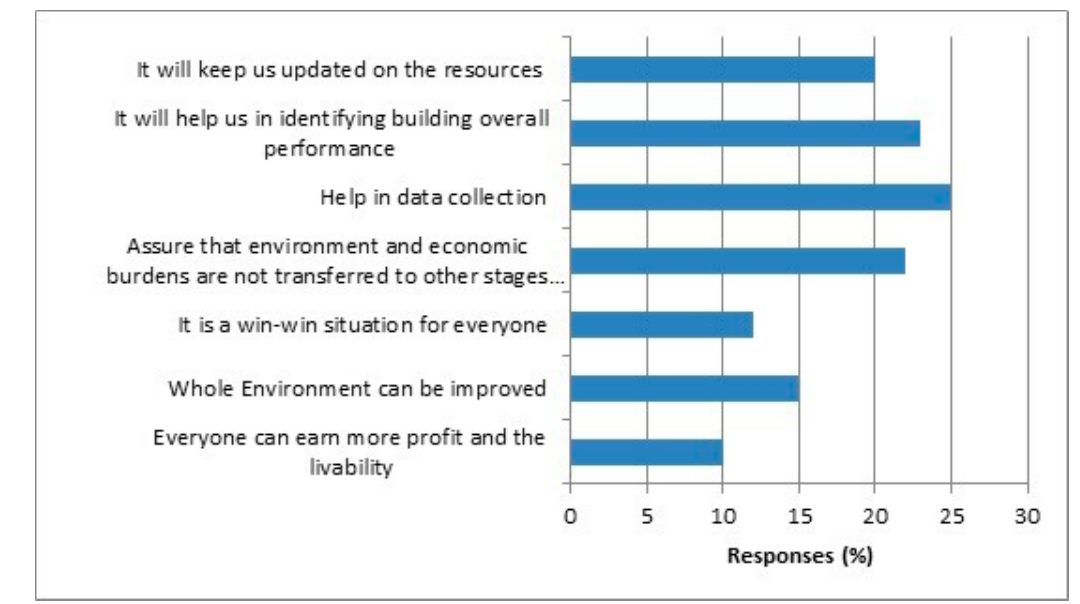
Figure 8. Benefits of a holistic framework as suggested by respondents.